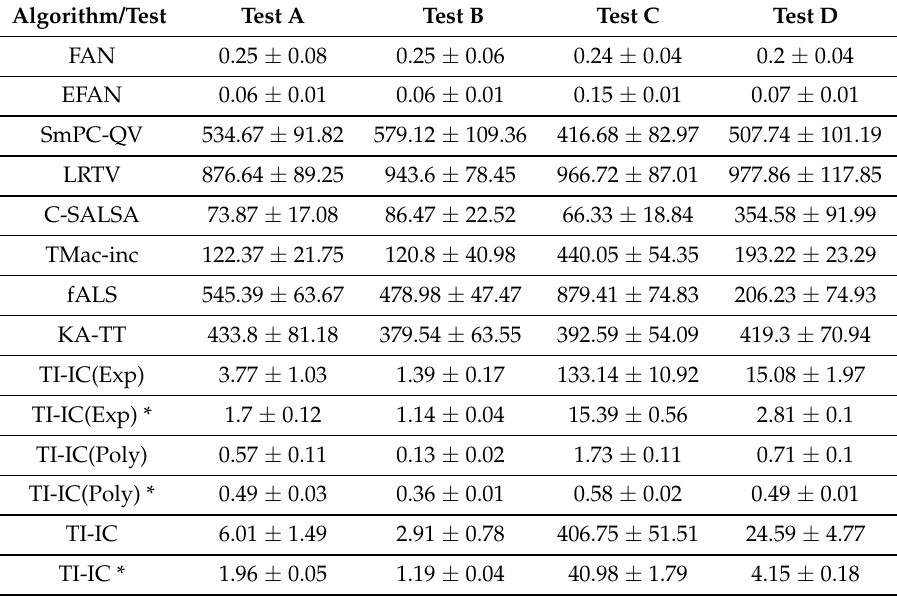
Figure 6. Box-plots of signal-to-interference ratio (SIR) performance for the tests ( A – D ) with the algorithms 1 = FAN, 2 = EFAN, 3 = SmPC-QV, 4 = LRTV, 5 = C-SALSA, 6 = TMac-inc, 7 = fALS, 8 = KA-TT, 9 = TI-IC(Exp), 10 = TI-IC(Poly), 11 = TI-IC. Table 1. Mean runtime (in seconds) of the algorithms and the corresponding standard deviations for each test case. An asterisk denotes the use of parallel processing with a parallel pool of workers in